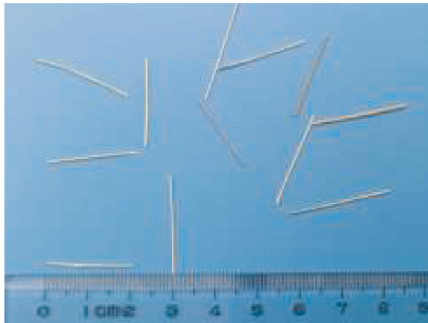
Figure 1: The practical photo of pasture fiber.